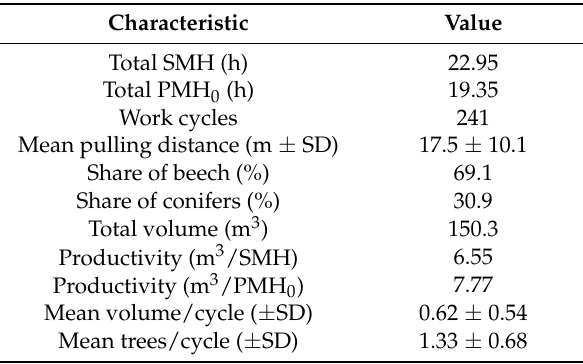
Table 4. Characteristics of the winching operations.